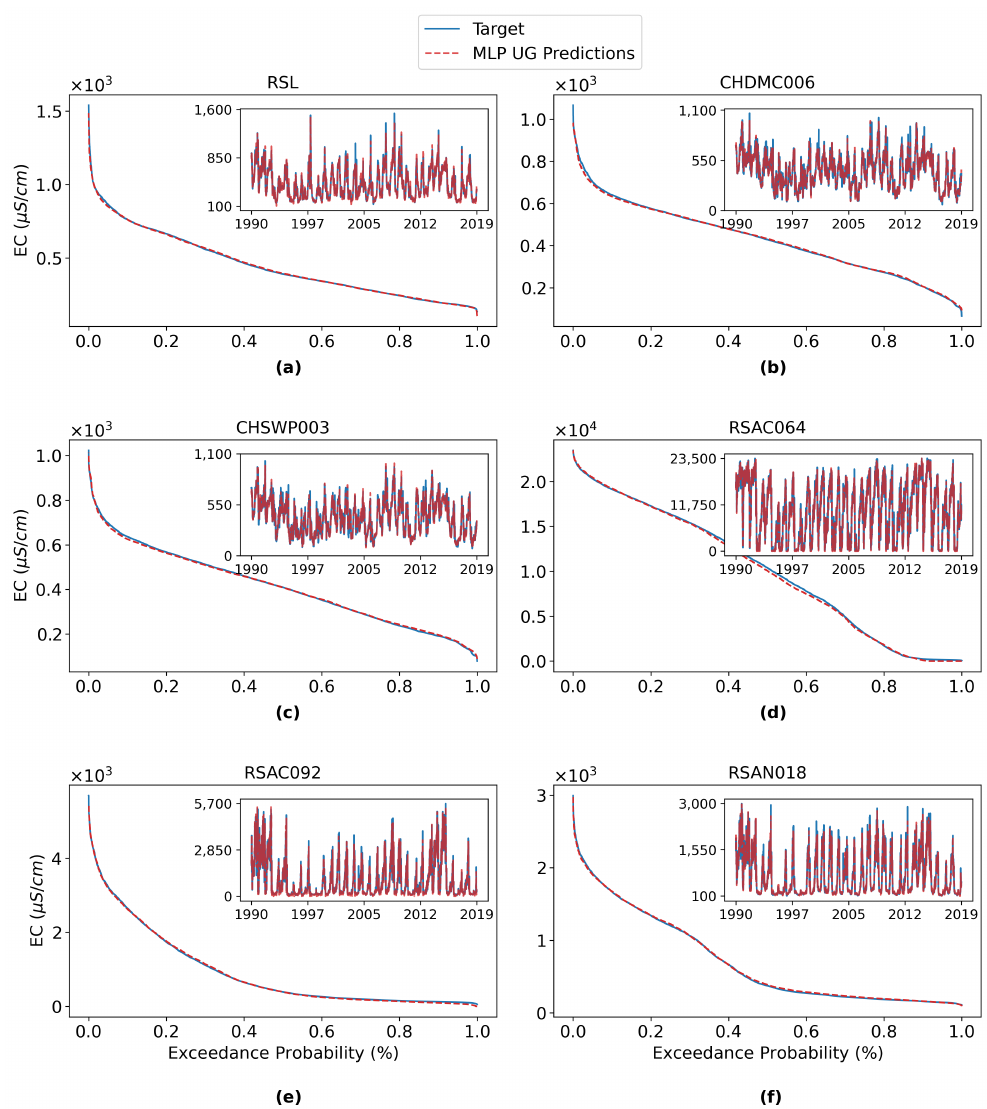
Figure A3. Exceedance probability curves and time series plots of salinity at six key study locations, including ( a ) RSL, ( b ) CHDMC006, ( c ) CHSWP003, ( d ) RSAC064, ( e ) RSAC092 and ( f ) RSAN018, comparing the ungrouped MLP model with the process-based DSM2 outputs.